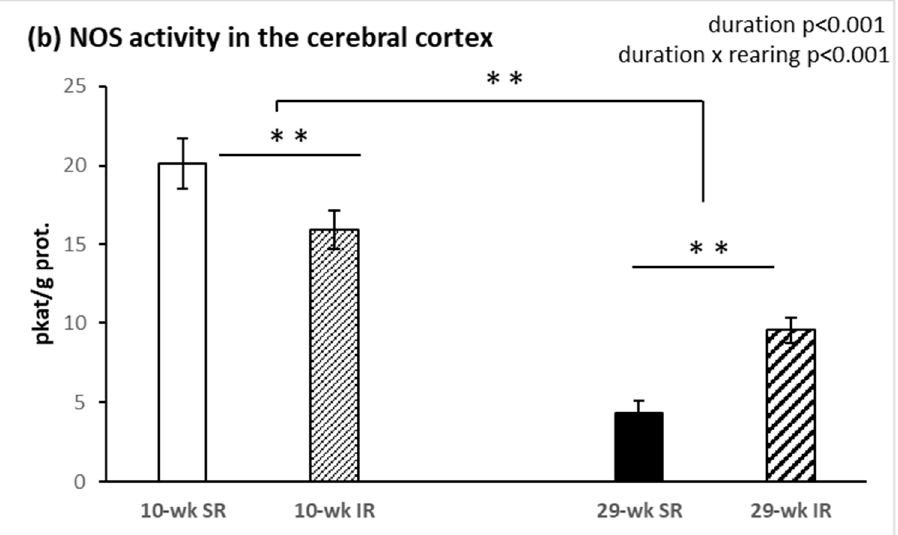
Figure 2. Effects of isolation rearing conditions on NOS activity in the cerebellum ( a ), and frontal cortex posterior to PFC ( b ). 10–wk SR, 10 week socially reared SD rats; 10–wk IR, 10 week isolation reared SD rats; 29–wk SR, 29 week socially reared SD rats; 29–wk IR, 29 week isolation reared SD rats; NOS, nitric oxide synthase; PFC, prefrontal cortex; SD, Sprague Dawley. Data are expressed as